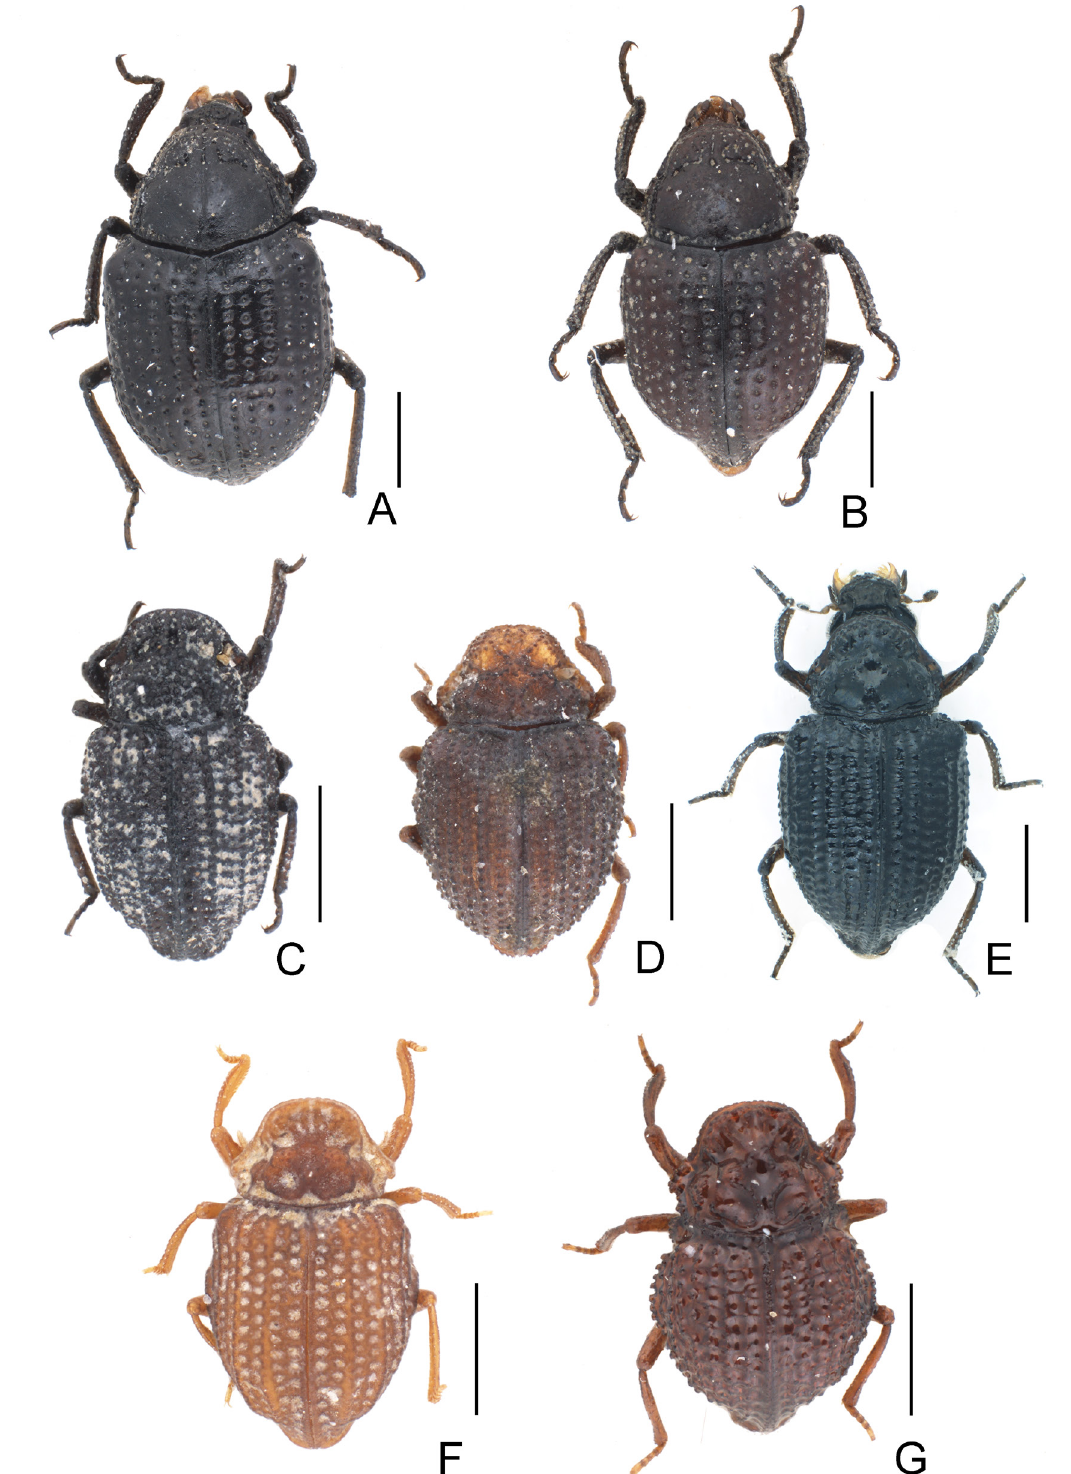
Fig. 2. Dorsal view of Georissus spp. A . G . ( G .) canalifer Sharp, 1888. B . G . ( G .) babai Satô, 1970. C . G . ( Ni .) granulosus Satô, 1972. D . G . ( Ne .) japonicus Satô, 1972. E . G . ( Ne .) kurosawai Nakane, 1963. F . G . ( Ne .) takahashii sp. nov., holotype, ♂ (EUMJ). G . G . ( Ne .) satoi sp. nov., holotype (EUMJ). Scale bars = 0.5